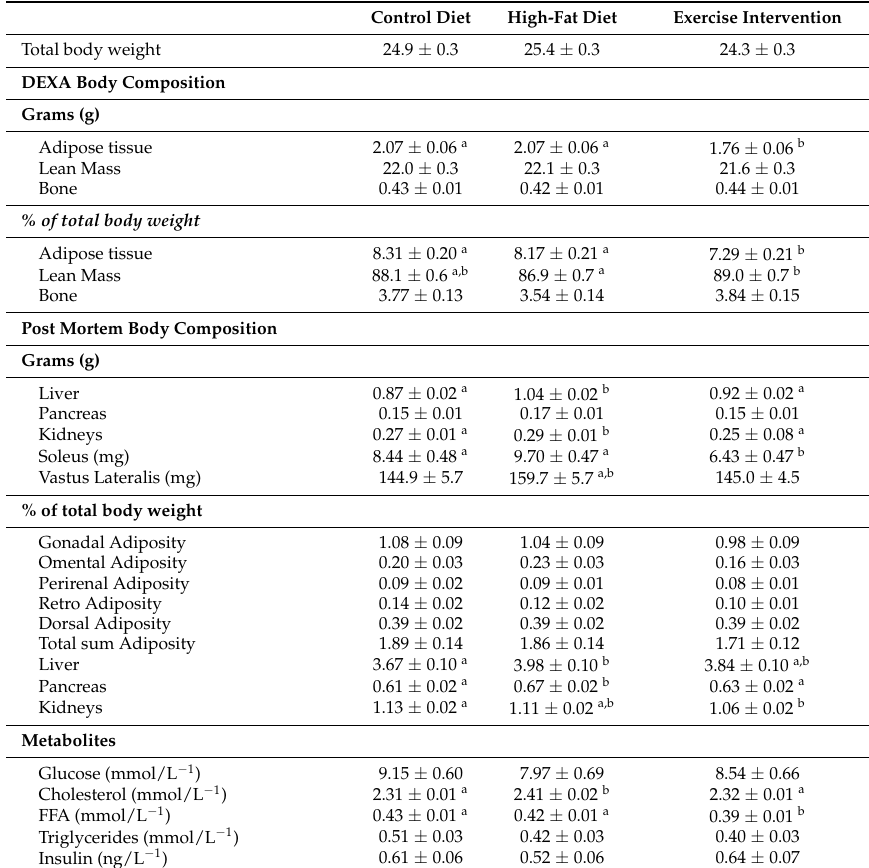
Table 2. Effect of founder high fat diet with exercise interventions on male offspring body composition and metabolites (18 weeks